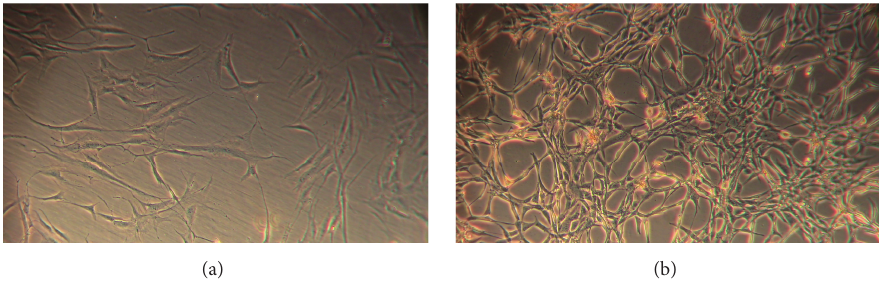
Figure 1: Morphological changes in passage 1 ASCs grown in tPR. 100,000 passage 1 ASCs were plated in T25 flasks and grown for 4 days in either 10% FBS or 10% tPR. (a) Morphology and density of FBS cultured cells after 4 days. (b) Morphology and density of tPR cultured cells after 4